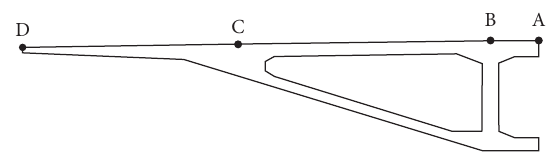
Figure 11: Main girder cross-section diagram at every